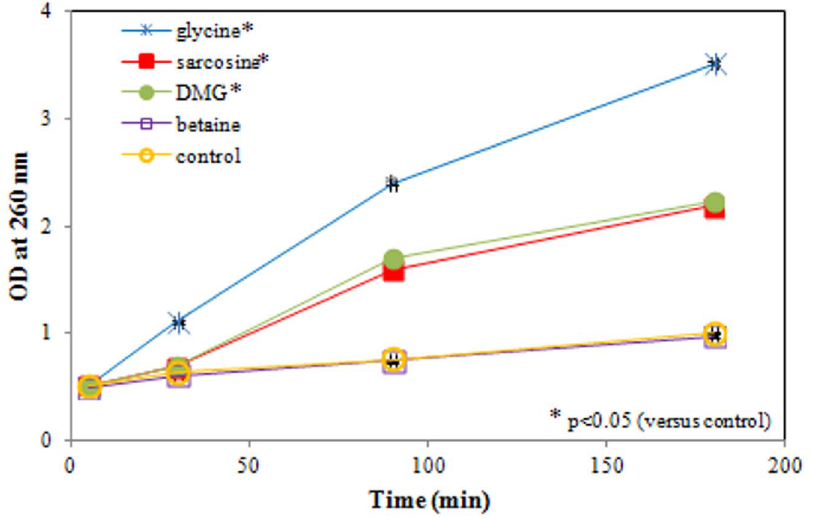
Figure 3. Leakage of 260-nm-absorbing material from E.coli . ETEC were exposed to glycine, sarcosine, DMG, betaine (50 mM, pH 9.5) and sterile PBS (control, pH 9.5) for up to 180 minutes. After 30 min of incubation there is a significant loss of 260-nm-absorbing material when incubated with glycine (p=0.003) and DMG (p=0.006). Exposure to sarcosine leads to a significant increased leakage after 90 min of incubation (p=0.001). Data are expressed as means 6 SD of triplicate experiments.